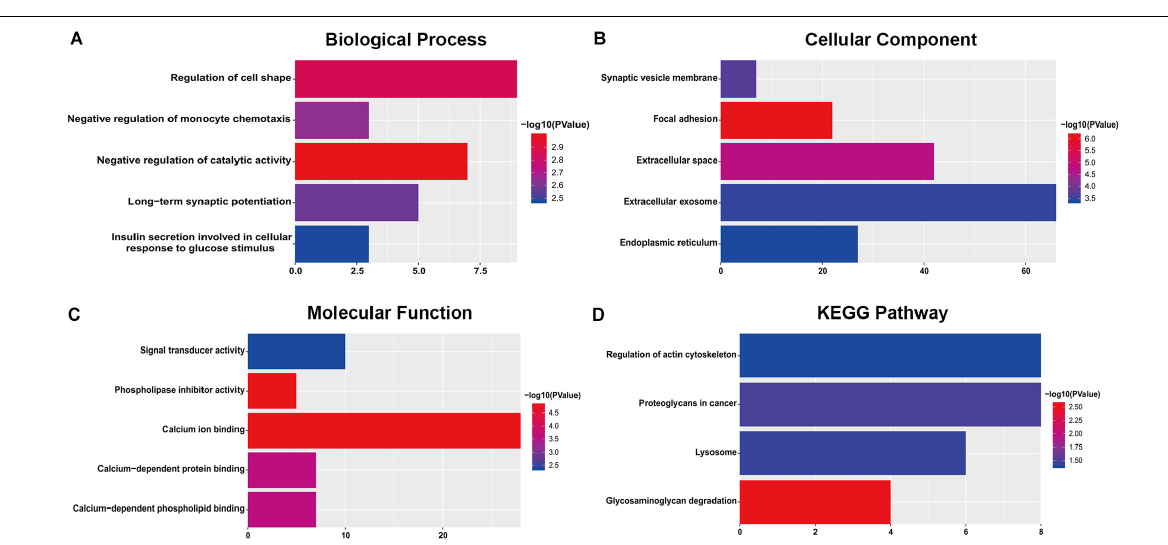
FIGURE 2 | The most significantly enriched GO annotations and KEGG pathways of genes related to survival. The length of the bars represents the number of genes, and the color of the bars corresponds to the p -value according to legend. (A) Top 5 significantly enriched biological process. (B) Top 5 significantly enriched